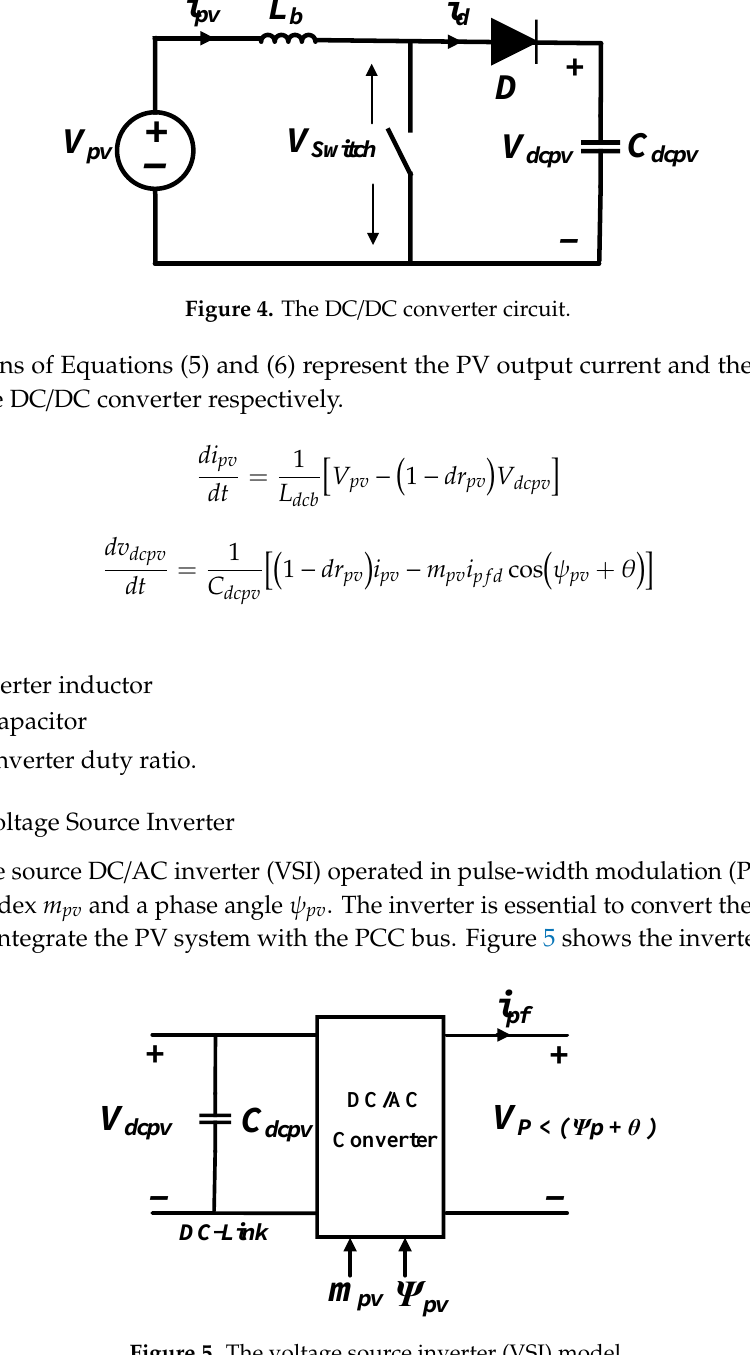
Figure 5. The voltage source inverter (VSI) model.